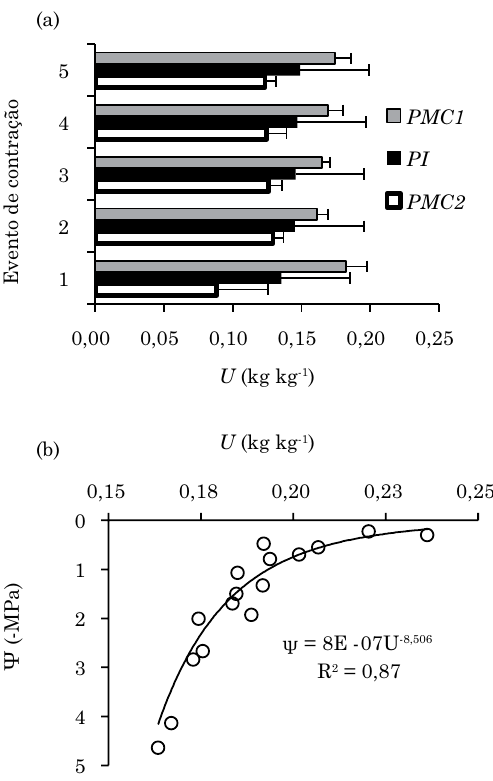
Figura 4. Conteúdo gravimétrico de água no solo ( U ) no primeiro ( PMC1 ) e no segundo ( PMC2 ) ponto de máxima curvatura e no ponto de inflexão ( PI ), obtidos por ajuste da equação (1) aos dados experimentais (a); e relação entre U e o potencial matricial (Ψ) (b). Linhas no extremo direito das barras representam o desvio-padrão.